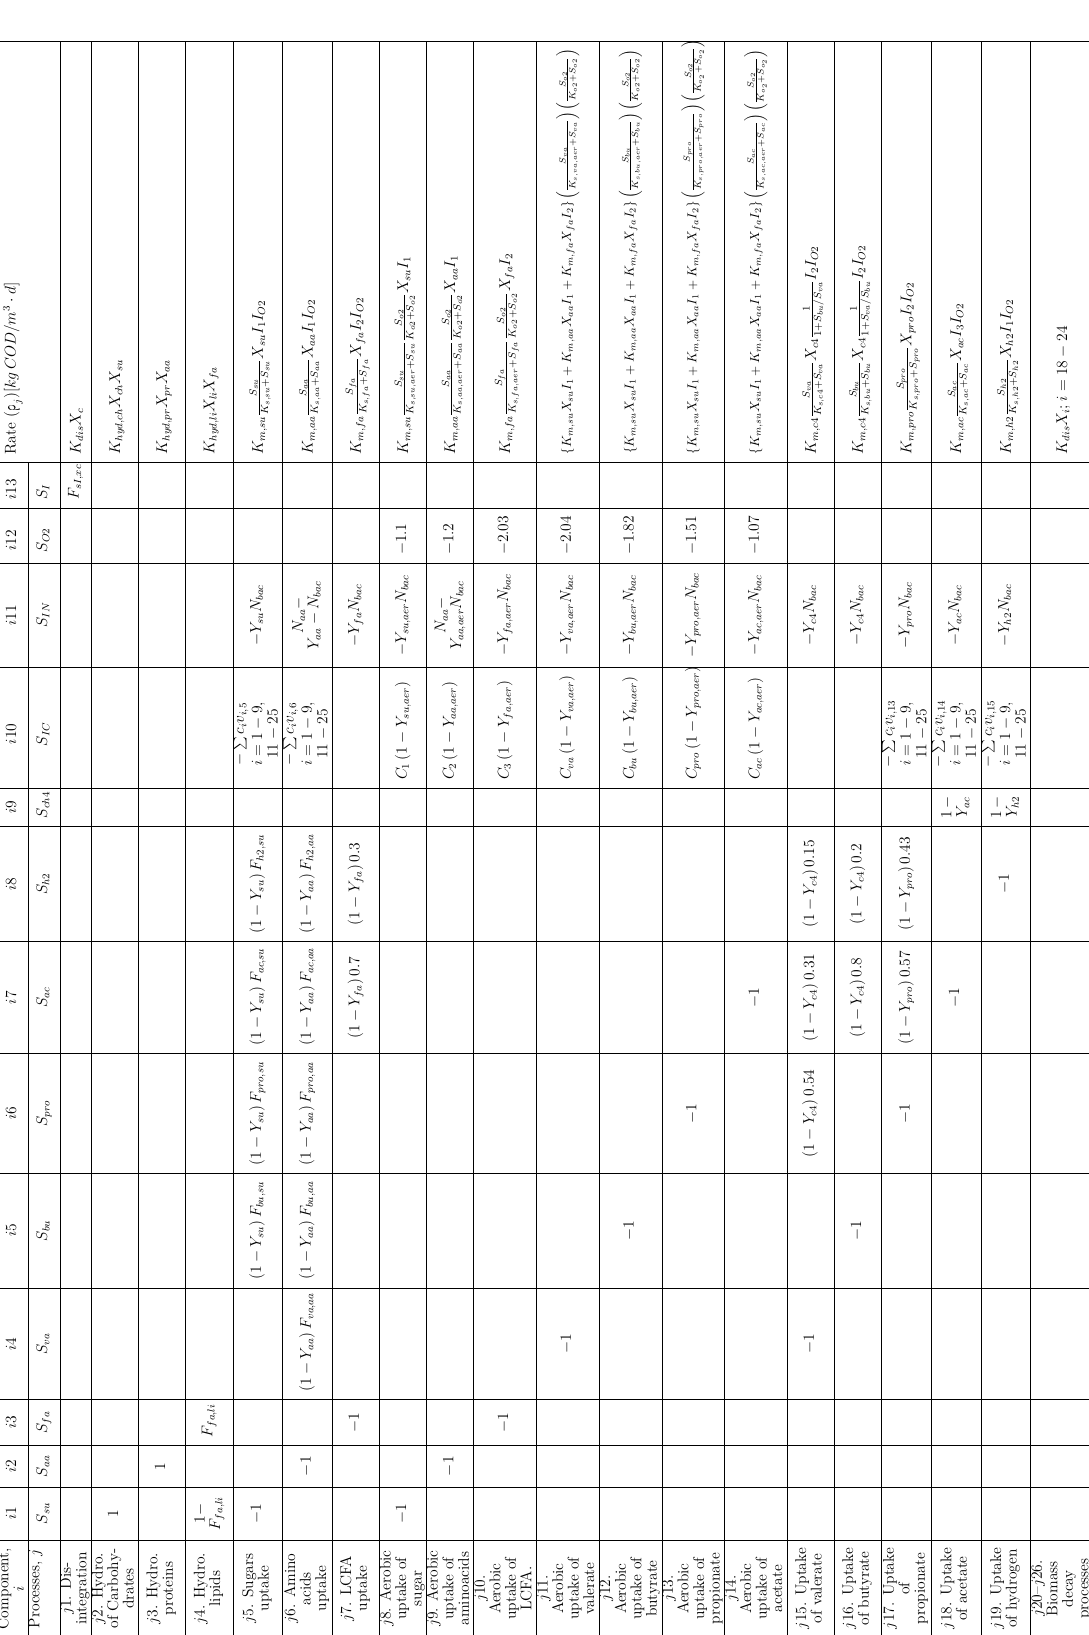
Table 1: Stoichiometric matrix of the ADM 1-Ox model for the soluble